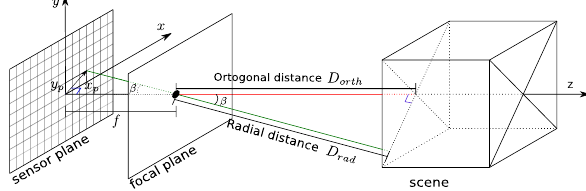
Figure 6. Transforming a radial distance into an orthogonal dis- tance, following (Rapp et al., 2008)